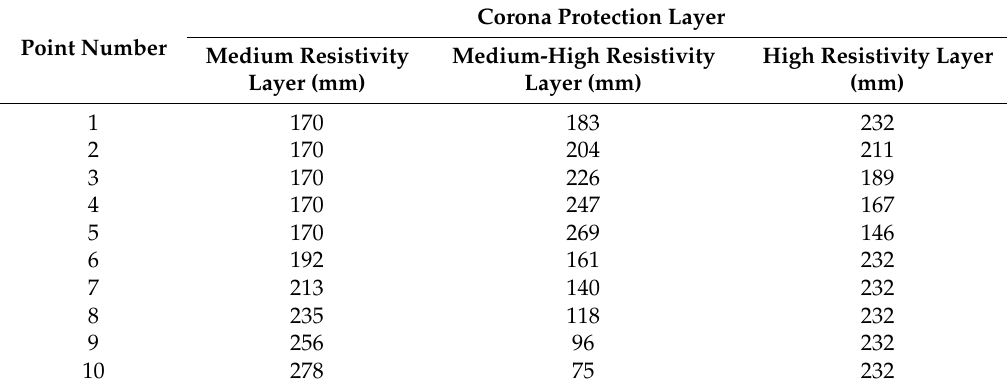
Table 1. Length of the corona protection coating for the medium resistivity